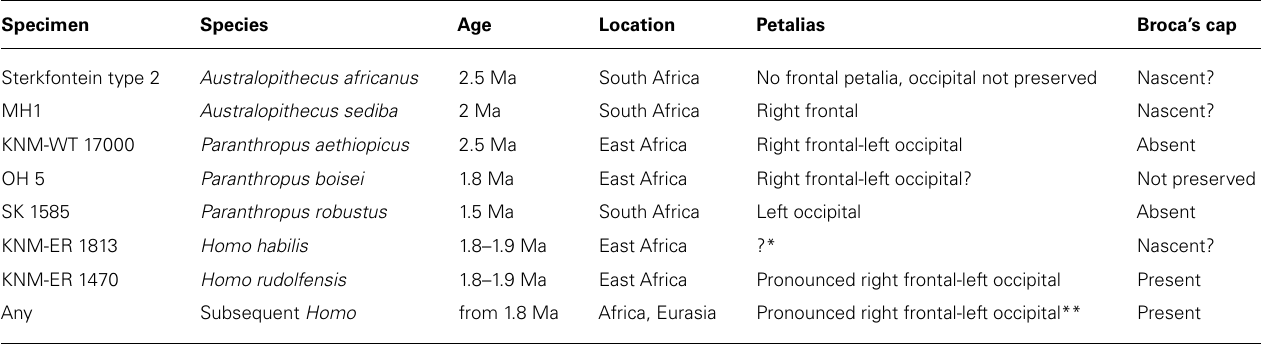
Table 1 | Endocranial asymmetries in selected fossil